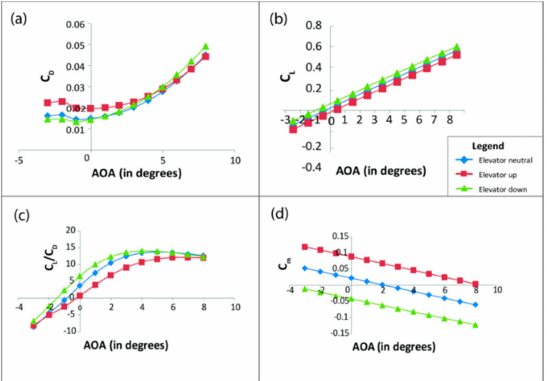
Figure 11. Change in aerodynamic parameters due to elevator deflection. Here, subfigure ( a ) shows the variation of C D (Coefficient of drag), ( b ) shows the variation of C L (Coefficient of lift), ( c ) shows the variation of C L /C D , and ( d ) shows the variation of C m (Coefficient of pitching moment) with varying angle of attack and fixed elevator deflection of 10 ◦ .